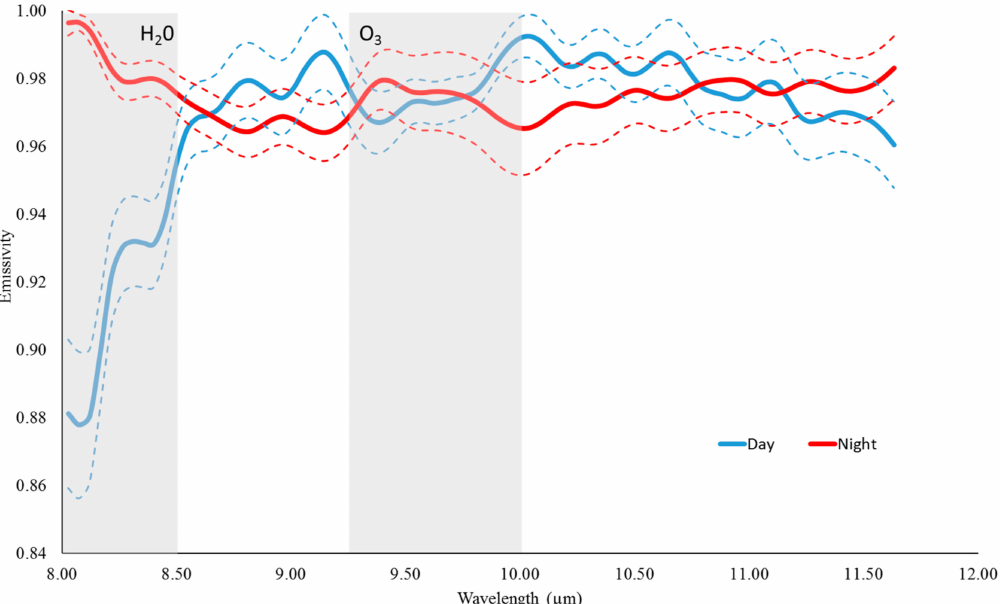
Figure 3. The mean atmospheric signal as represented by the 199 selected pixels with a DNSO value of 0.83 for day (solid blue) and night (solid red). Standard deviation marked as dashed lines. Gray shading marks the main atmospheric features’ regions (water vapor and tropospheric